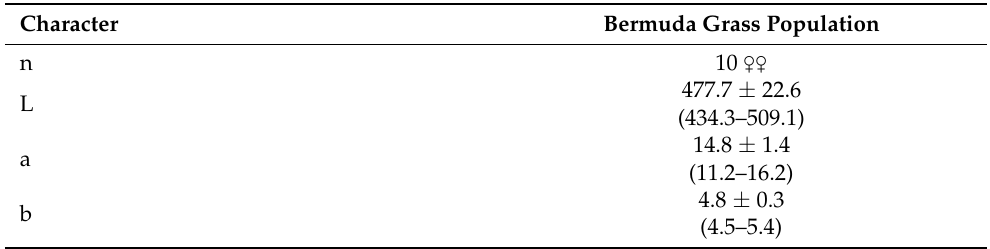
Figure 2. Adult female of Hemicriconemoides rosae . ( A ): Entire body; ( B , C ): Anterior body; ( D ): Excretory pore (ep arrow); ( E – G ): Tails (a refers to anus, v refers to vulva) (Scale bars: ( A ) = 50 µ m; ( B – G ) = 10 µ m). Table 5. Morphometrics of females of Hemicriconemoides rosae populations mounted in formalin– glycerin. All measurements in µ m and in the format: mean ± s.d.